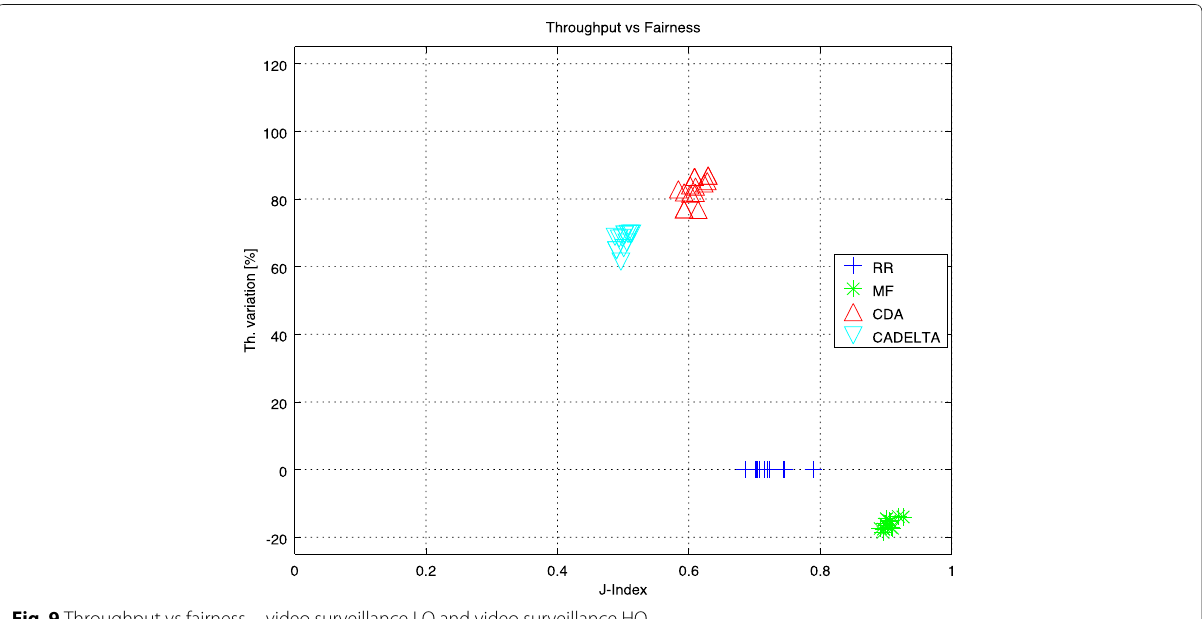
Fig. 9 Throughput vs fairness—video surveillance LQ and video surveillance HQ